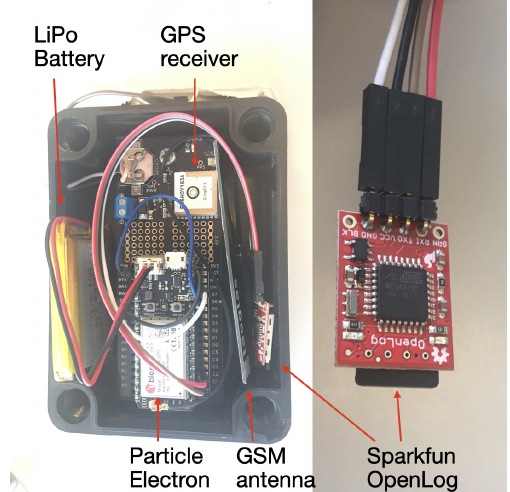
Figure 1. Photo of the electronics components. The left photo iden- tifies the Asset Tracker, Electron and OpenLog. The right photo shows the OpenLog in